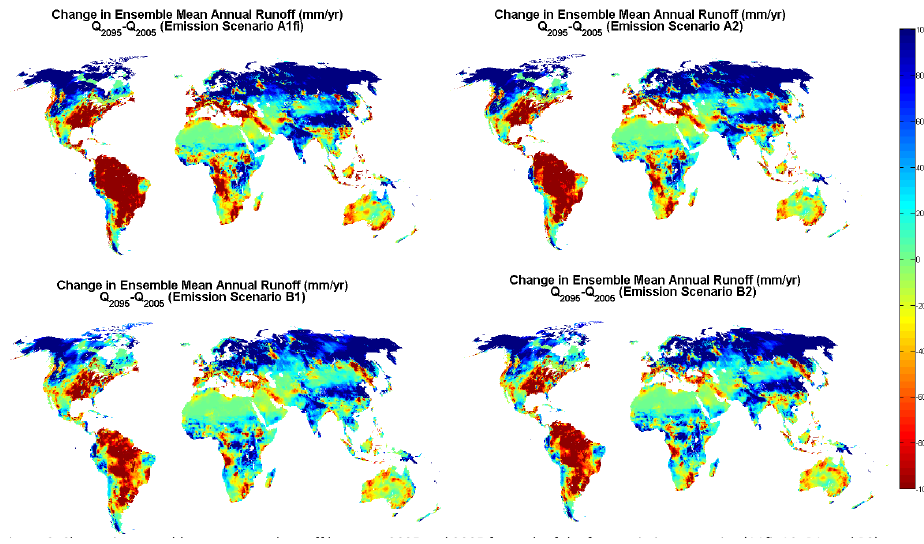
Figure 6: Change in ensemble mean annual runoff between 2095 and 2005 for each of the four emission scenarios (A1fi, A2, B1, and B2).